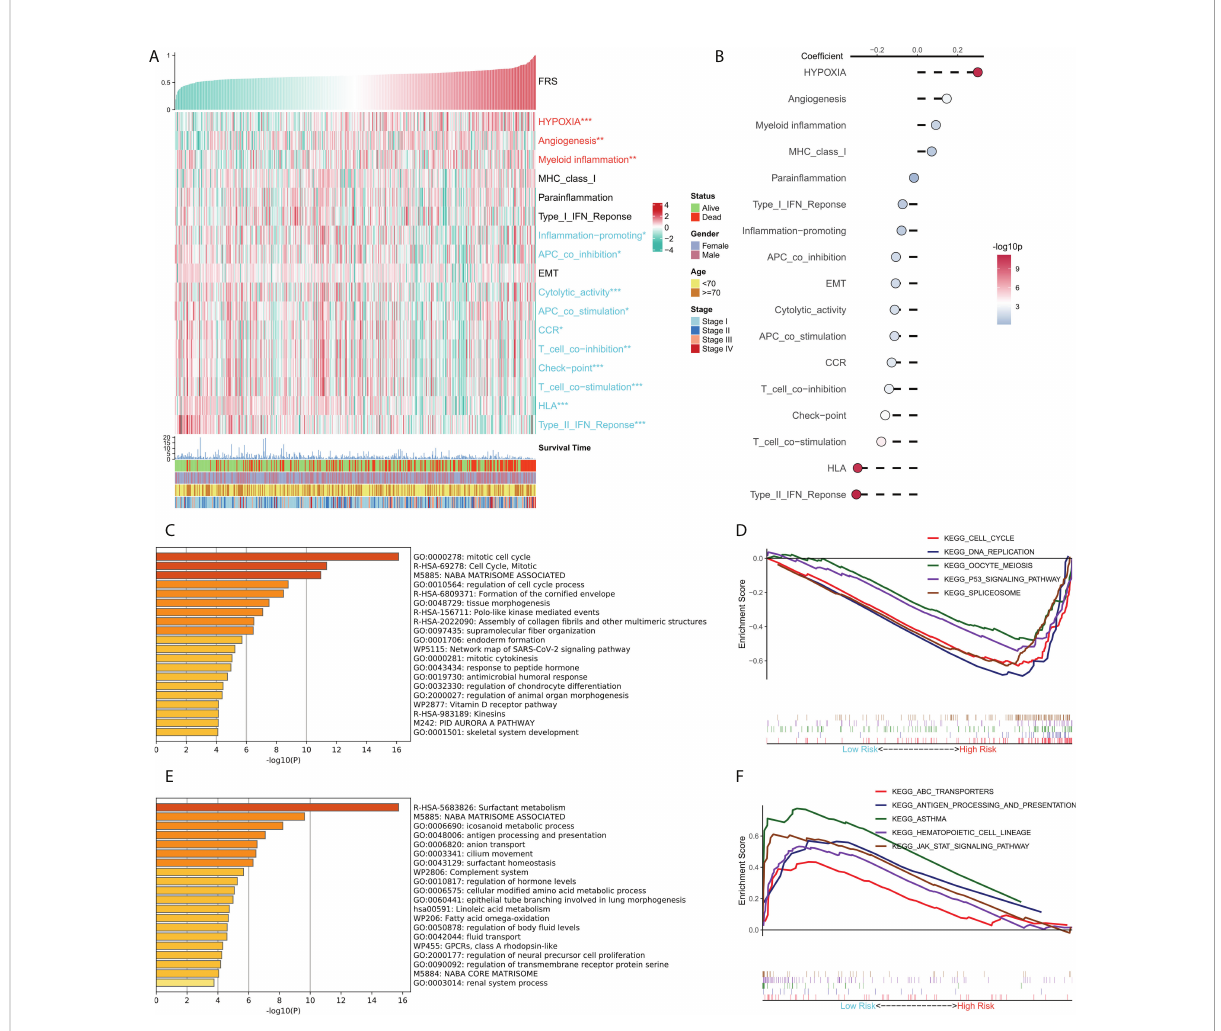
FIGURE 5 Functional analysis for FRS. (A) Heat map showing the correlation between FRS, biological pathway activities, and clinical characteristics; (B) Correlational analysis of FRS and biological pathways; (C) Functional enrichment analysis of the upregulated genes in the high group; (D) GSEA enrichment plot showing the fi ve pathways of interest in the high group; (E) Functional enrichment analysis of the upregulated genes in the low group; (F) GSEA enrichment plot showing the fi ve pathways of interest in the low